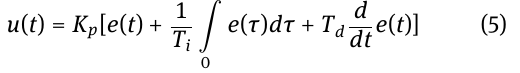
Figure 1: Momentum factor with respect to iteration in different values of α .